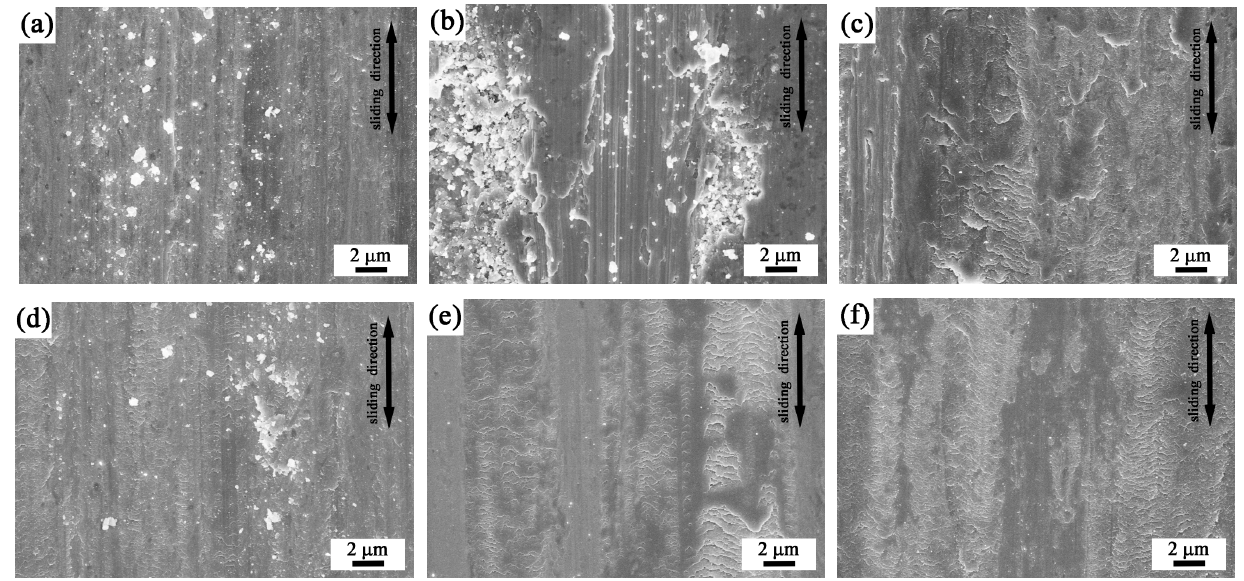
Fig. 4 SEM micrographs of worn surface of SUS304 balls tested under the loads of 1 and 9 N: (a, b) against TTS sample, (c, d) against TSS-1 sample, and (e, f) against TSS-2 sample.